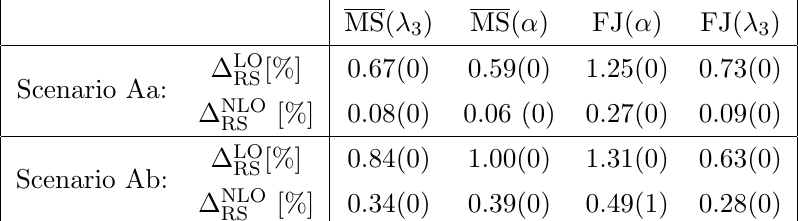
Table 3 . The variation (cid:1) RS of the h ! 4 f width in scenarios Aa and Ab at the central scale (cid:22) 0 using di(cid:11)erent renormalization schemes (with NLO parameter conversions). The columns correspond to the schemes in which the input parameters are de(cid:12)ned. The technical uncertainty in brackets is calculated by exploiting the integration errors for the central values corresponding to the maximal and the minimal